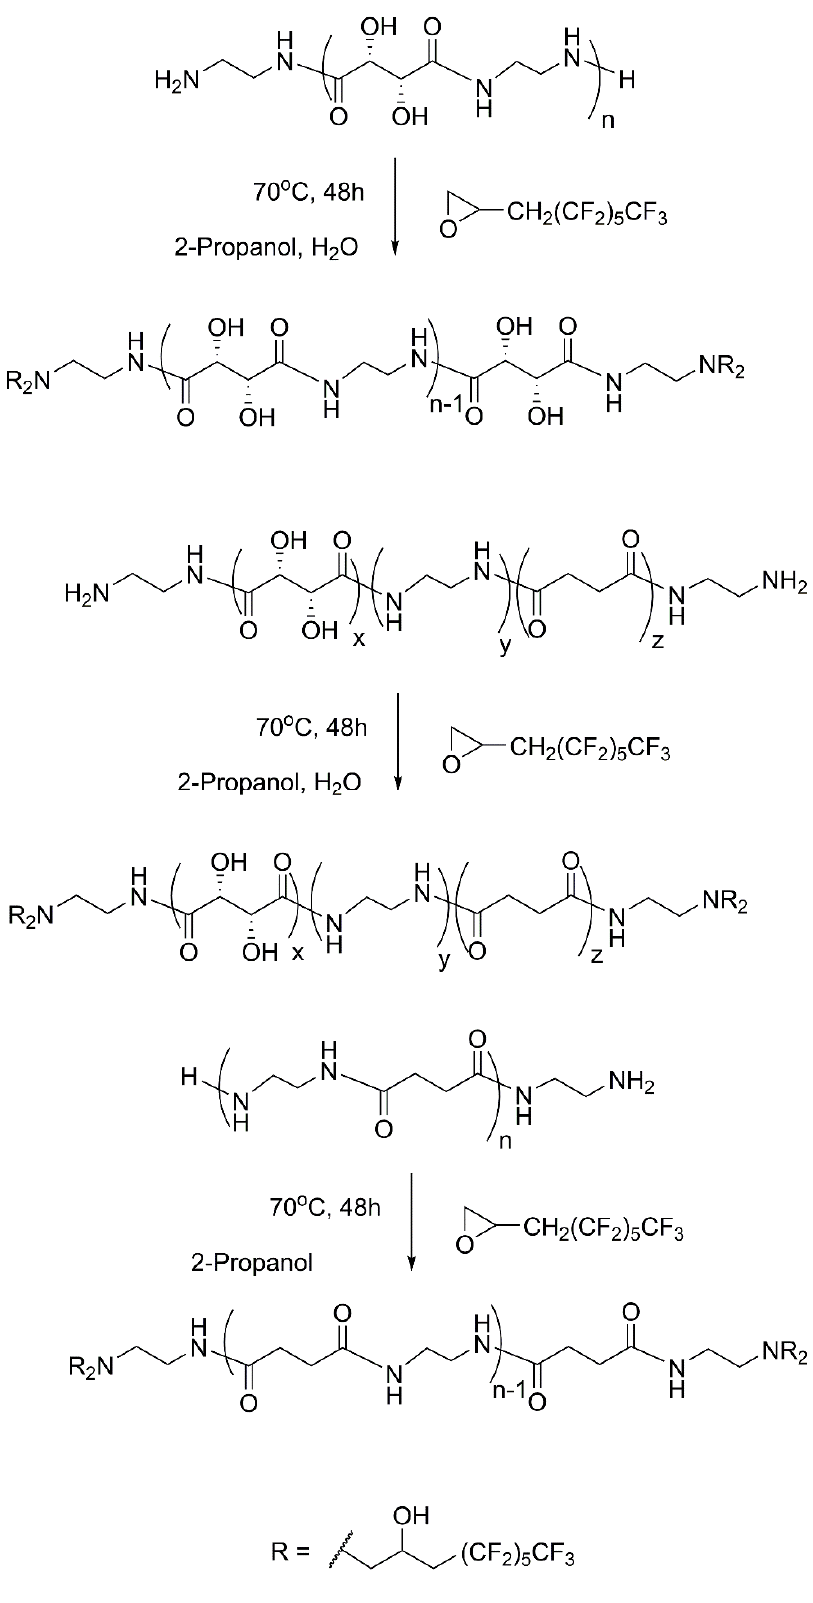
Figure 6. Scheme of the synthesis of fluorinated oligoamides (ETF, ESTF, ESF). The best reaction conditions resulted in a molar ratio OA/EC6F of 1:4 and heating at 70 °C for 48 h. Using a 2-propanol/water mixture as a solvent in the ratio 3:1, higher conversion and degree of substitution values were obtained compared to the 1:1 ratio.